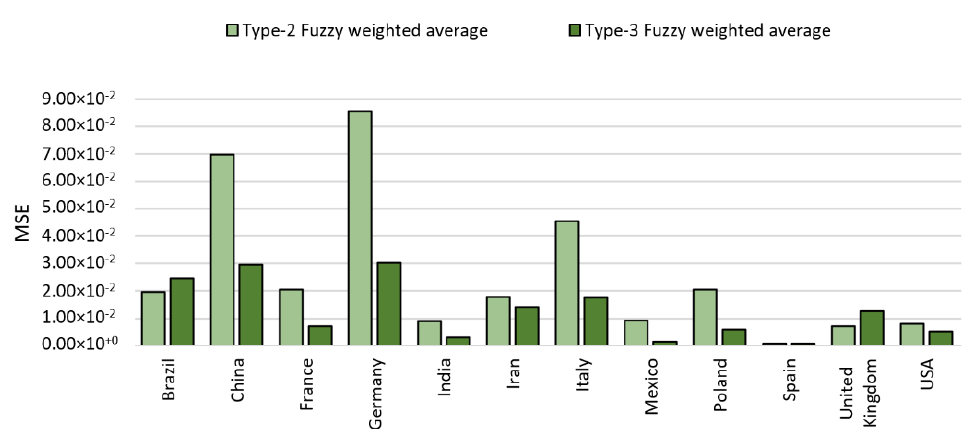
Figure 27. First data period (future prediction).